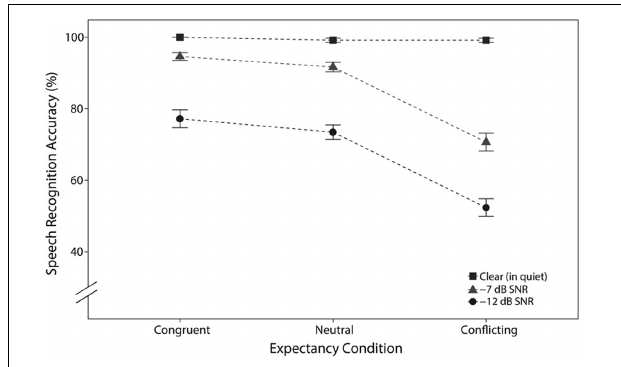
FIGURE 3 | Mean ( ± SE) for task accuracy, averaged across participants, for each expectancy and listening condition.